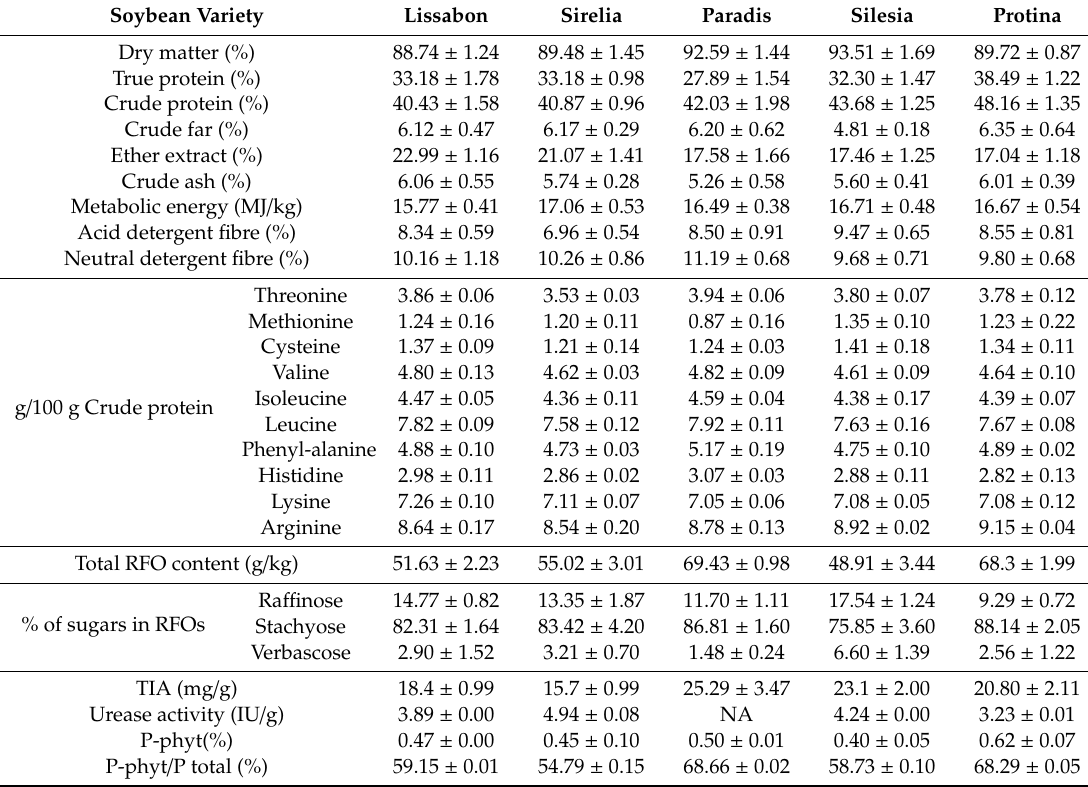
Table 4. The average chemical composition of di ff erent soybean seeds varieties (% in DM) with a high level of protein (above 40% in